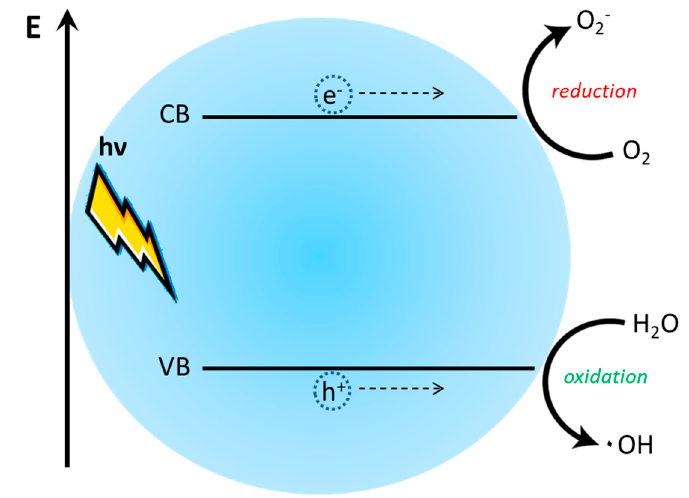
Figure 22. Schematization of the photo-induced formation of the radical O 2• − and the formation of the hydroxyl radical (OH • ).